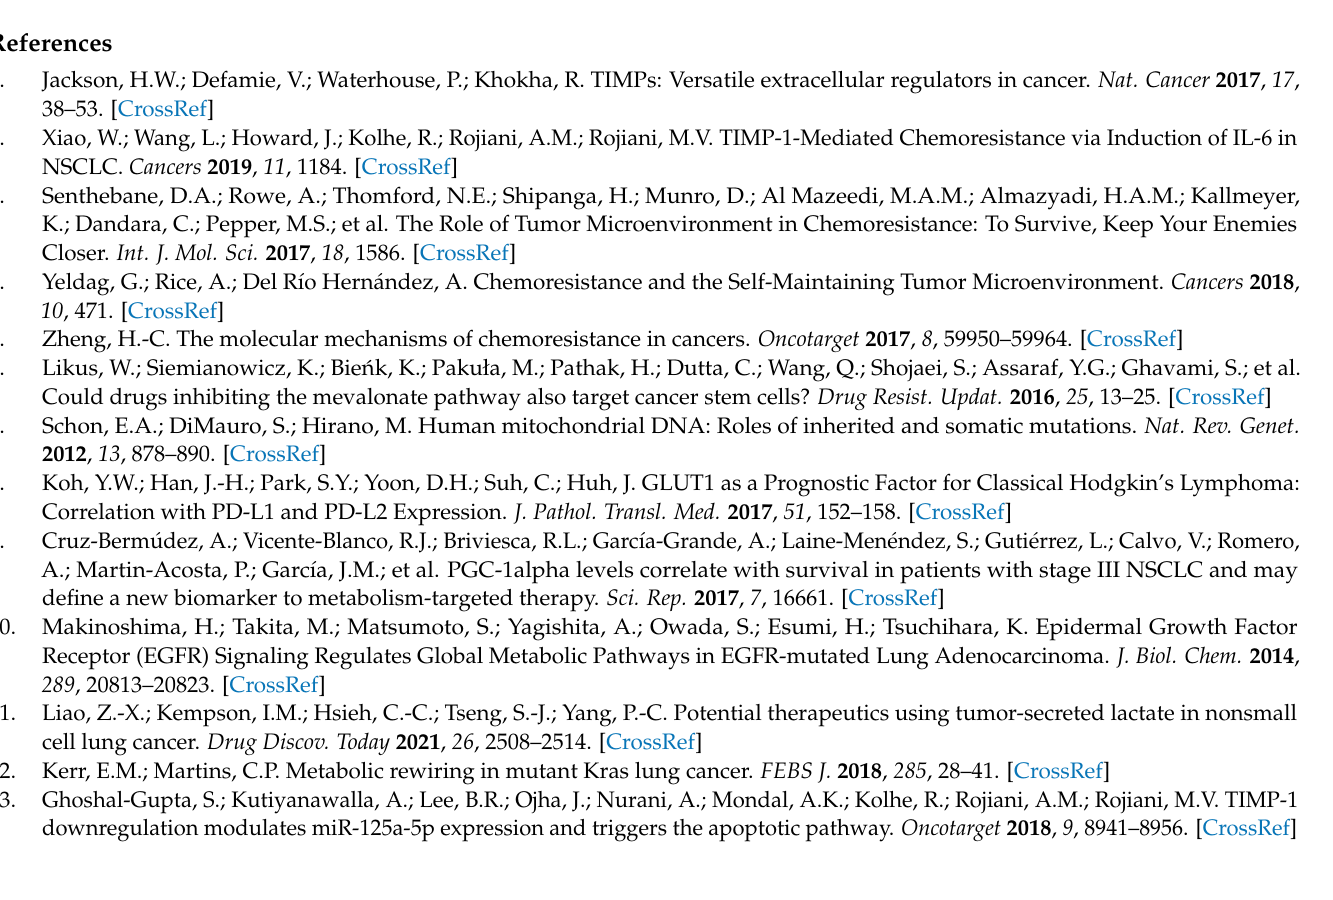
Table S3: Gene list of ‘Energy Metabolism’ in WikiPathways; Table S4: Correlation of immune cells with the prognostic genes in LUAD